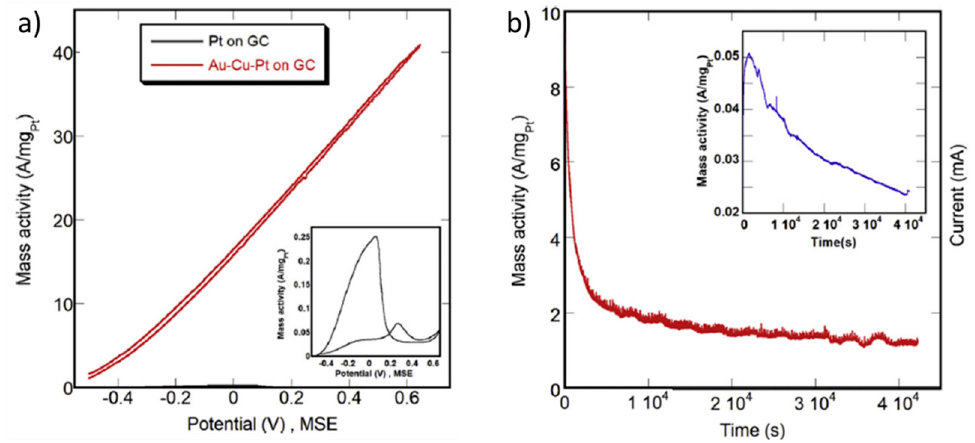
Figure 4. ( a ) Cyclic voltammetry, at 50 mV s − 1 , and ( b ) chronoamperometry at 0.7 V vs. RHE, of PtAuCu (2.6 at. % Pt) in 2 M HCOOH + 0.1 M HClO 4 . Inset figures show the measurements performed on bare Pt. Reprinted with permission from Ref. [80].